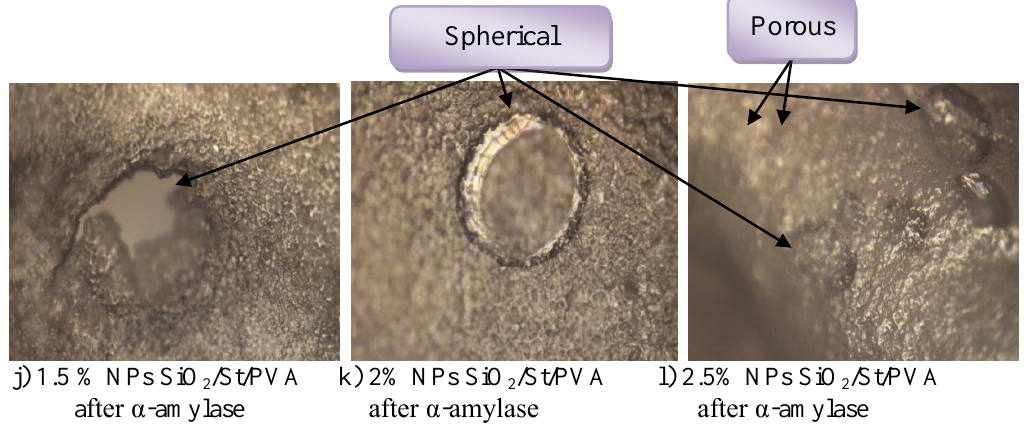
Fig. 12: SiO µPs and NPs before and after α-amylase 2